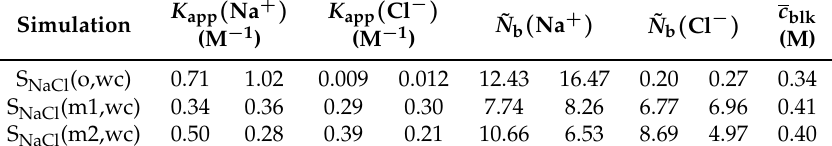
Table 2. Apparent binding constants K app (Equation (21)) for sodium and chloride ions, computed from ions binding to either leaflet (which is why two values are reported; Section 4.3.2), the corresponding numbers of bound ions ˜ N b ( Na + ) and ˜ N b ( Cl − ) , respectively (Equations (19) and (20)), and mean salt concentration in the bulk c blk (Equation (22)). The underlying ion density profiles along the bilayer normal are displayed in Figure 1 (S NaCl (o,wc)), Figure 2 (S NaCl (m1,wc)) and Figure 3 (S NaCl (m2,wc)). The simulation acronyms are explained in Table 7.